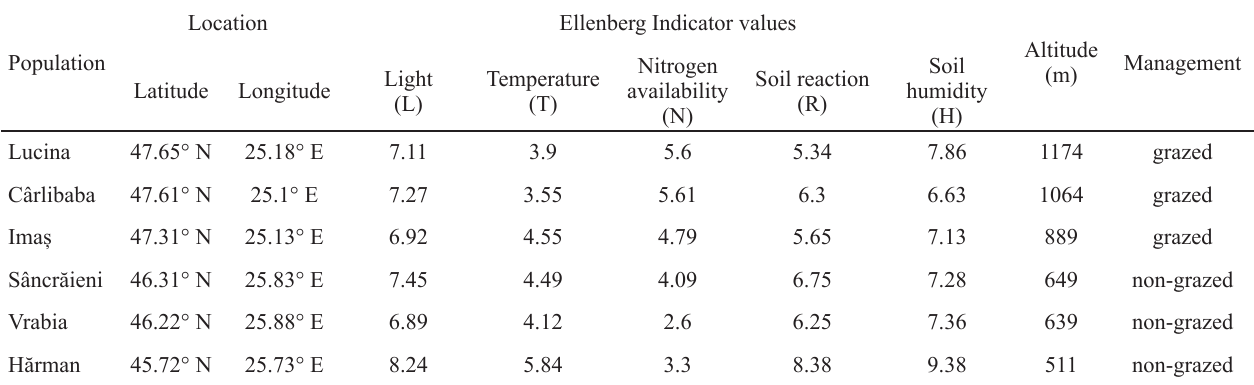
Table 1 – Characteristics of the studied populations and localities of Ligularia sibirica . The values of the Ellenberg indicators represent the weighted mean area for each relevé.